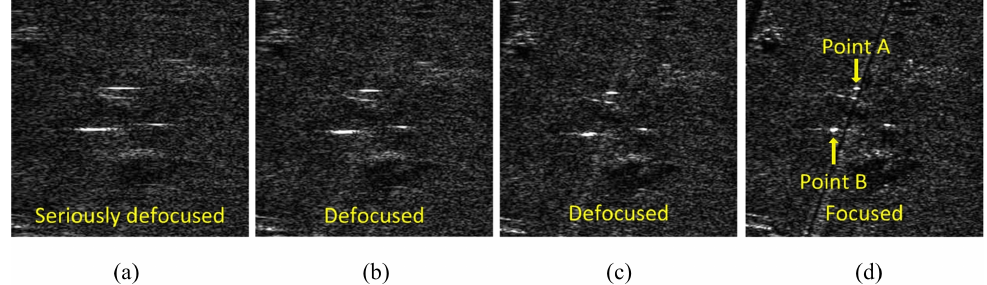
Figure 20. Magnified sub-scene images 2. ( a ) Processed with INS-only MOCO. ( b ) Processed with conventional MDA. ( c ) Processed with RDMDA. ( d ) Processed with 2D-SVMDA.